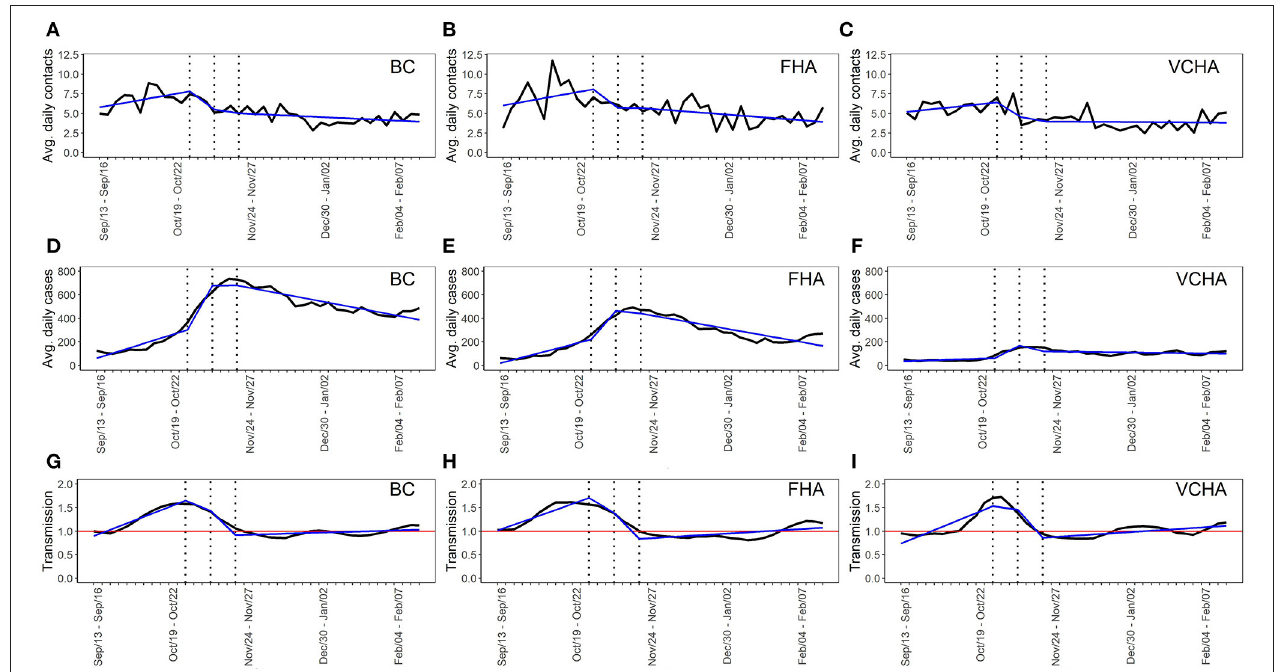
FIGURE 1 | Time series of average daily contacts (contact rates), average daily cases (new cases) and transmission (R t ) of COVID-19 in BC (A,D,G), FHA (B,E,H) and VCHA (C,F,I) from September 13, 2020 to February 19, 2021. The vertical dotted lines indicate dates of announcement of public health contact-restriction orders on